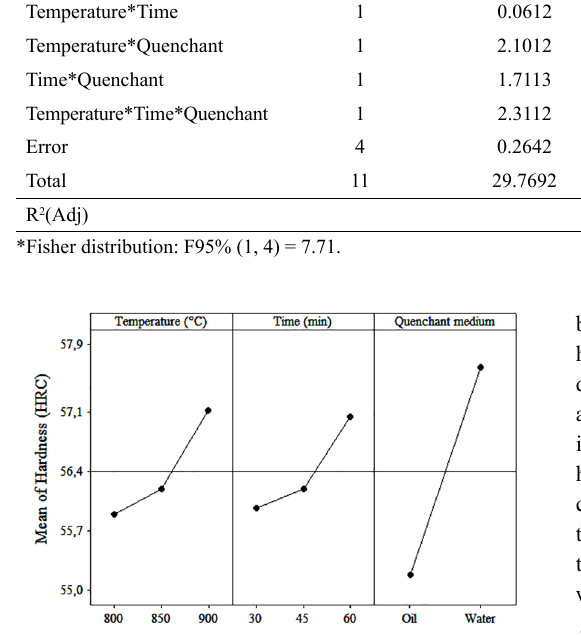
Figure 4. Main effects plot (data means) for Hardness (HRC).